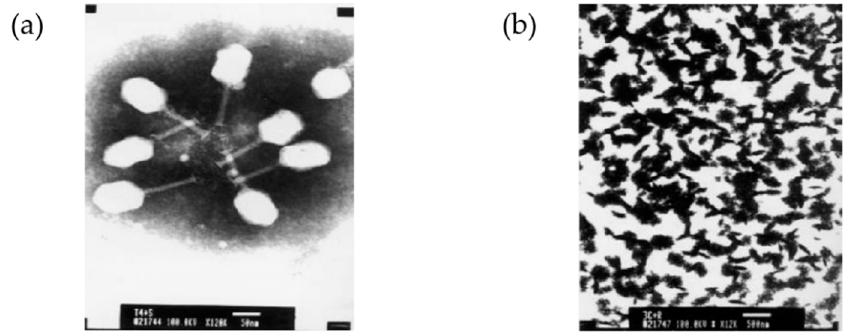
Figure 11. The head of bacteriophage T4 as a pathogenic display system. ( a ) Negatively stained image of the recombinant T4-3C phage particles (scale bar: 50 nm, magnification 12kx); ( b ) aggregation–precipitation of phages due to the addition of pig anti- foot-and-mouth disease (FMDV)-O antibody into the mixture of E. coli BL21 (DE3) infected phage T4-P1 and recombinant T4-3C phage particles (scale bar: 500 nm, magnification 12kx). Reprinted from [103], copyright (2008), with permission from Elsevier.